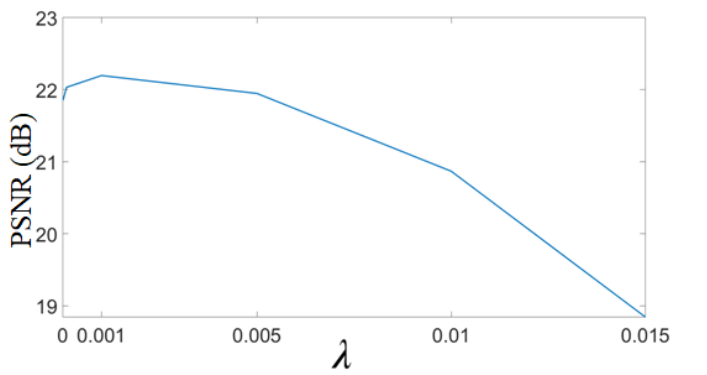
Figure 12. Optimal selection of parameter λ in the super resolution approach. A random MR image is selected and upscaled by factor 2 using the proposed super-resolution (SR) approach. The HR image is obtained with different values of λ in Equation (3), and the obtained PSNR values are